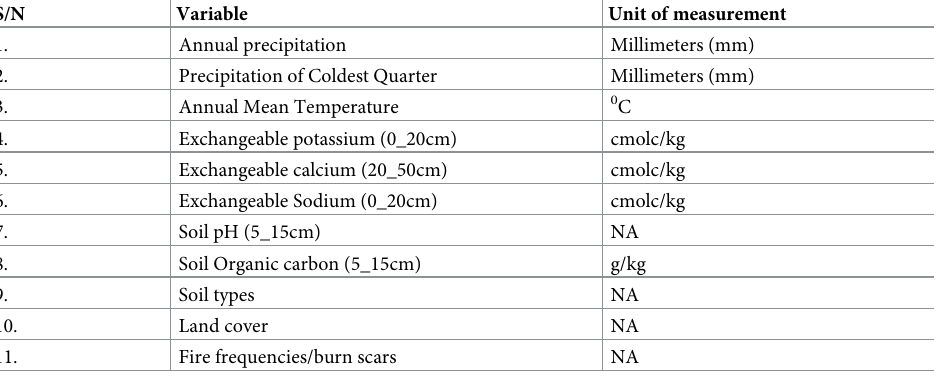
Table 3. Final predictor variables used in modeling suitable environmental conditions supporting anthrax distri- bution and spore survival in